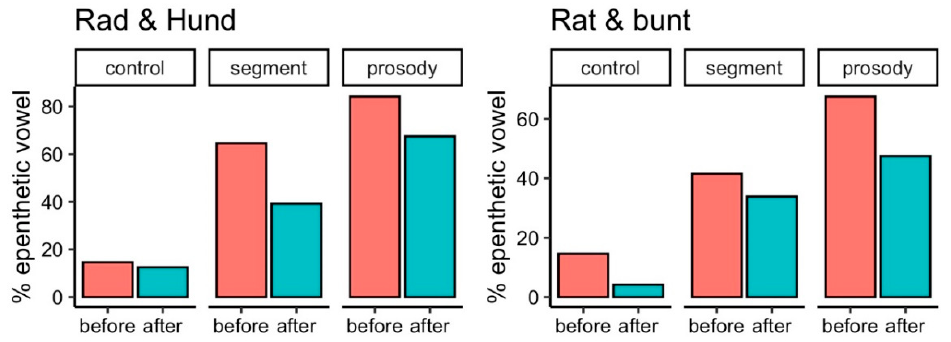
Figure 2. Percentages of epenthetic vowel occurrence for training groups before and after training.